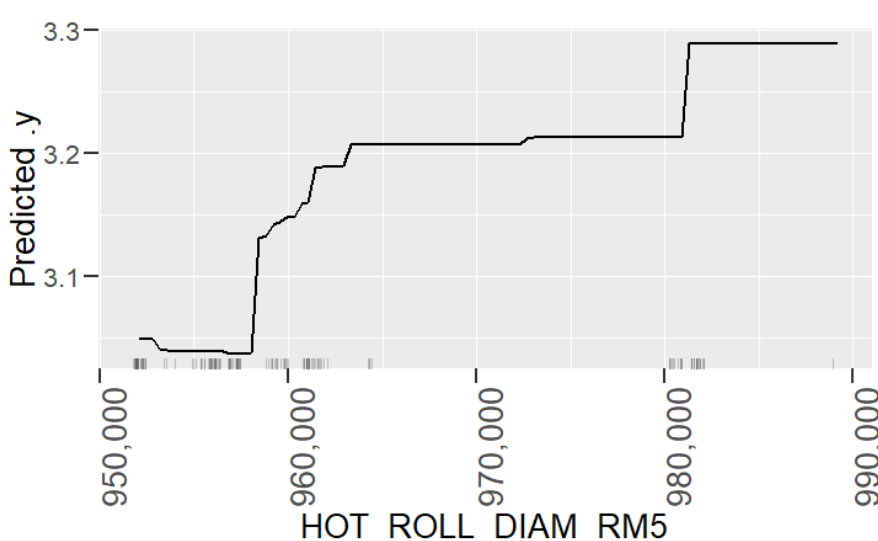
Figure 10. PDP of the average pickling speed.